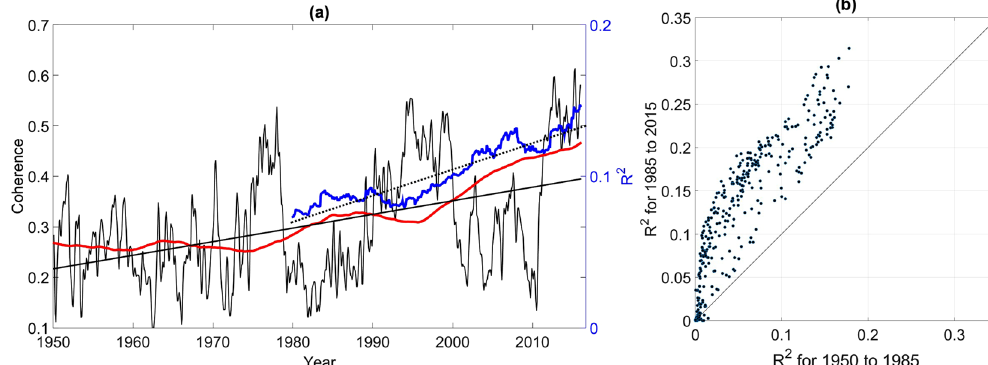
Figure 5. EP/NP Index Correlation and Coherence with Temperature. ( a ) Mean 30-year sliding squared correlation coefficient time series (blue curve) averaged across all 344 climate divisions for which statistically significant EP/NP-temperature relationship were identified in each 30-year segment. The scale-averaged wavelet coherence averaged across all US climate divisions is represented by the black curve. The stippled line represents the trend in coherence from 1980 to 2015 and the dotted line represents the trend from 1950 to 2015. Thick red line is the 30-year running mean of the coherence time series. Coherence and the mean 30-year sliding squared correlation coefficient time series are plotted on different scales. ( b ) R 2 -values in the 1985 to 2015 segment plotted as a function of the R 2 -values in the 1950 to 1980 segment. Points falling on the diagonal line represents those climate divisions for which no difference was